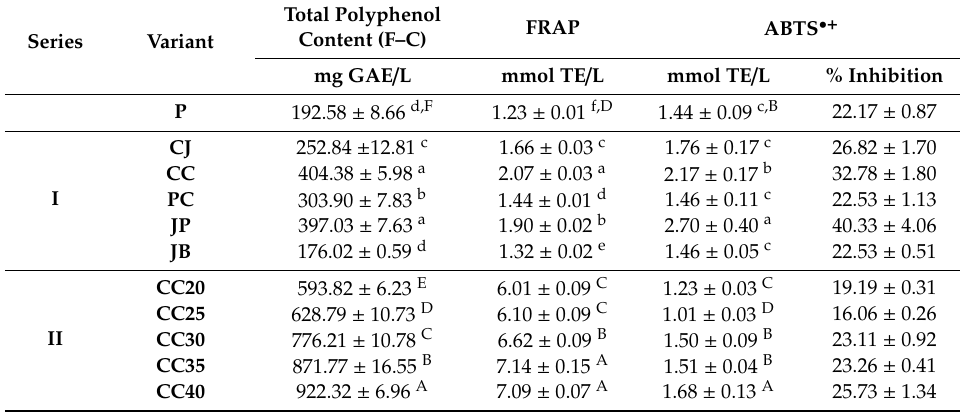
Table 2. Characteristics of wort produced with selected dark malts and roasted barley grains in terms of polyphenol content and antioxidant activity expressed with FRAP (ferric reducing antioxidant power) and ABTS • + (2,2 (cid:48) -Azino-bis(3-ethylbenzothiazoline-6-sulfonic acid) diammonium salt) methods. Total Polyphenol FRAP ABTS • + Content (F–C) Variant mg GAE / L mmol TE /